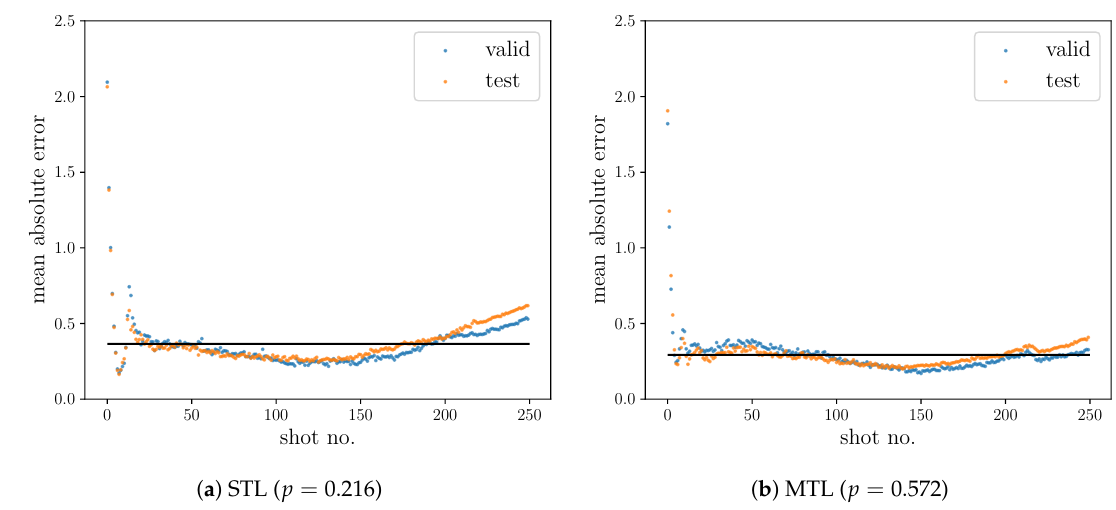
Figure 5. The comparison of MAE of Shot No. Regression over each shot no. between ( a ) STL and ( b ) MTL is significantly different as well ( p < 0.001). The black lines denote the MAE over the validation and test